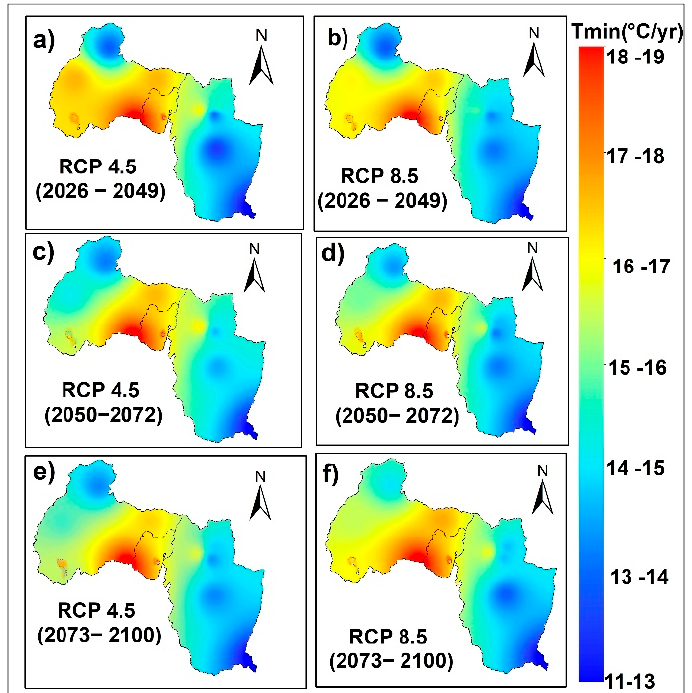
Figure 7. Spatial distribution of CNRM-CM5 model mean annual T min (°C) within the ZLB for RCP 4.5 and 8.5 scenarios and three future periods: ( a ) near-term RCP 4.5, ( b ) near-term RCP 8.5, ( c ) mid-term RCP 4.5, ( d ) mid-term RCP 8.5, ( e ) far-term RCP 4.5, and ( f ) far-term RCP 8.5.